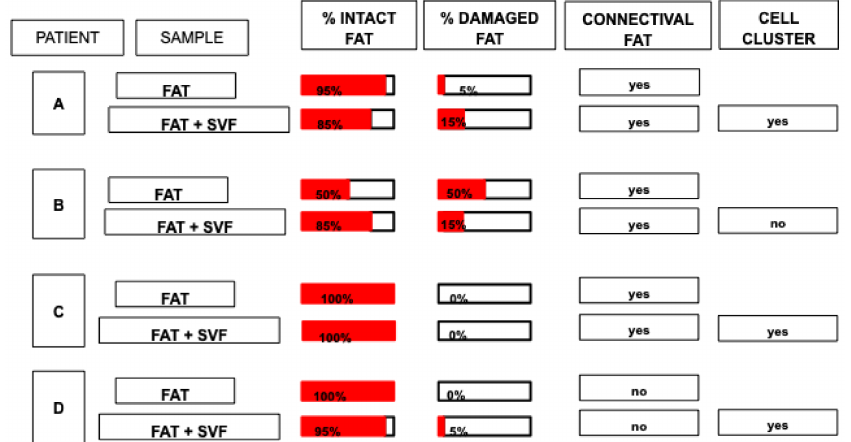
Figure 2. A summary of a histological analyses of randomized selection of FAT and FAT + SVF samples conventionally defined by the letter ( A – D ) (n = 4). All samples were composed predominantly by ‘intact fat’ and 3 out of 4 samples displayed a variable fraction of ‘damaged